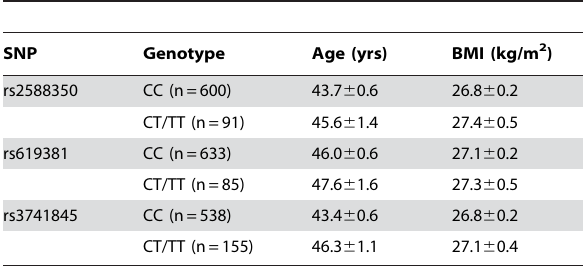
Table 4. Age and BMI values, according to genotype, for AFDS subjects in Table